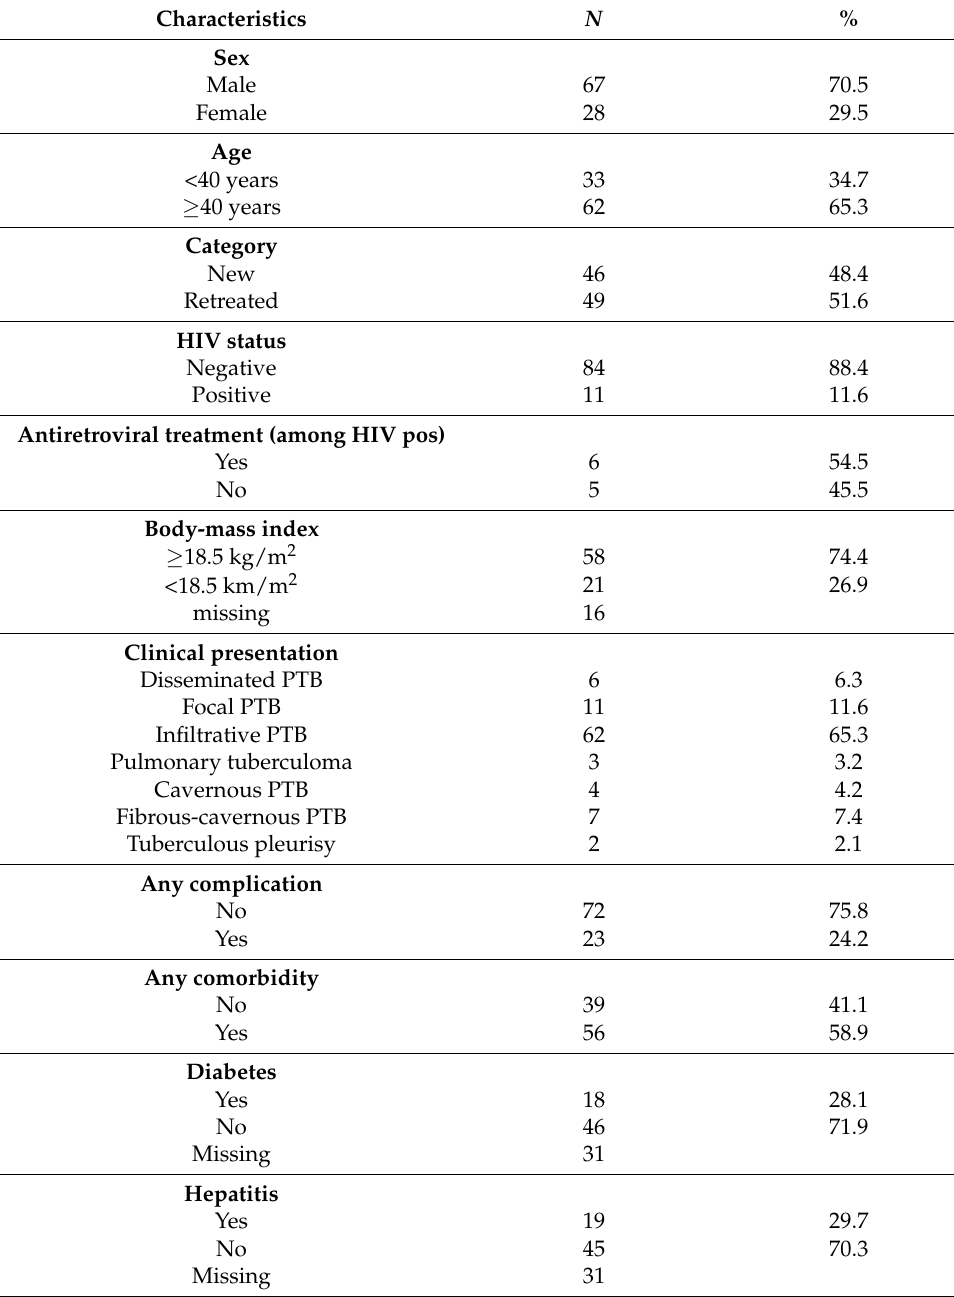
Table 1. Clinical and demographic characteristics of rifampicin-resistant tuberculosis (RR-TB) patients enrolled into shorter treatment regimens (STR) in Tashkent city (2018–2019), ( n = 95).